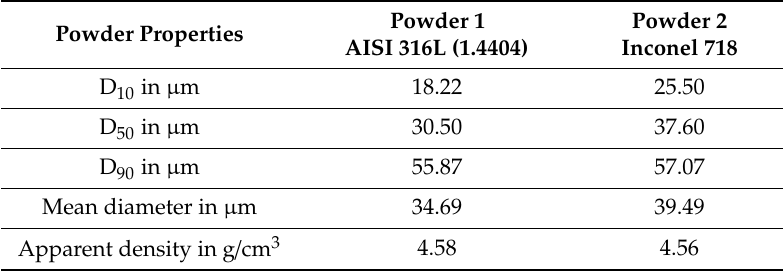
Table 1. Powder properties according to supplier’s